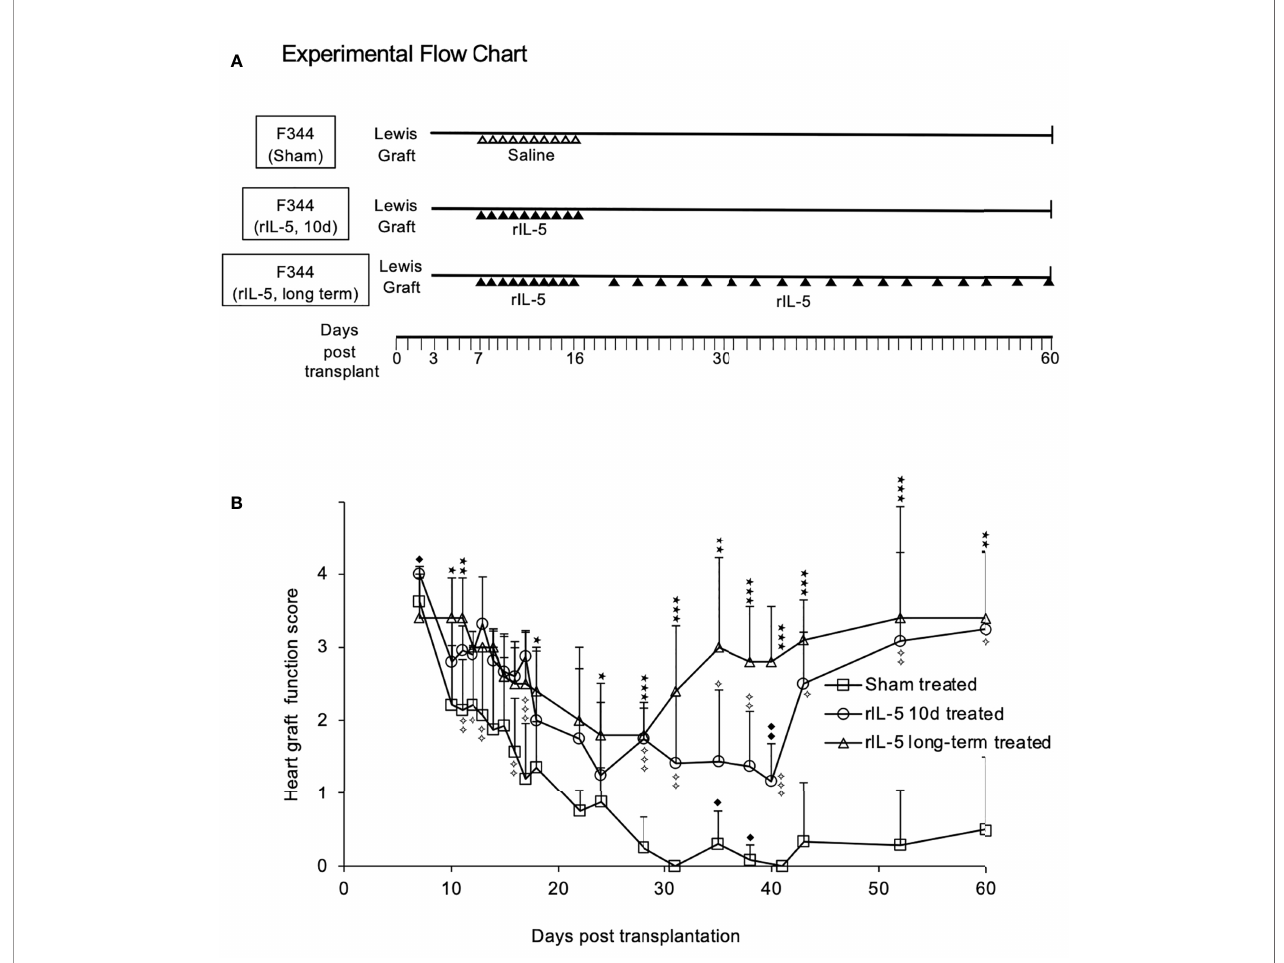
FIGURE 3 | IL-5 treatment prevents rejection of Lewis heart grafts in F344 hosts. (A) Experimental Flow Chart. Groups of F344 rats with heterotopic Lewis heart grafts were studied. Sham treated rats received saline (ipi) daily from day 7-16 post-transplantation. One treatment group (short-term rIL-5) received 5000 units/day of rIL-5 (ipi) from day 7 to 16 post-transplant. The second treatment group (long term IL-5) received rIL-5 therapy 5000 units/day from day 7-16 and beyond 16 days had three ipi of 5000 units rIL-5 per week until 60 days post transplantation. (B) Monitoring of F344 rats with Lewis heterotopic cardiac allografts. Severity of rejection was assessed by palpation and scored on a semi-quantitative scale, described in methods. Severity of rejection scores in each group was expressed as mean ± standard deviation. Sham treated ( □ ) received daily injections of 0.5ml of normal saline ipi starting at day 7 through to day 16 (n=5). All grafts had severe rejection by day 21. After 28 days, the mean score was <0.5 and there was no recovery of graft function. Short term rIL-5 treatment for 10d ( ○ ). 5000 units of rat rIL-5 was given daily ipi in 0.5ml from day 7 through to day 16 (n= 12), as described (22). Rejection was signi fi cantly less than sham treated on day 16 (p<0.01) and at day 17 (p<0.001). From day 28, graft function improved and was signi fi cantly greater than sham treated controls until day 60 (p<0.05). Signi fi cance compared to sham treated controls; ✧ p<0.05, ✧✧ P<0.01; ✧✧✧ p<0.001. Long-term rIL-5 treated ( △ ). 5000 units of rat rIL-5 in 0.5ml was given ipi in 0.5ml daily from day 7 through to day 16, then 3 times a week until day 60 (n= 5). Rejection in this group was signi fi cantly less (p<0.01) than sham treated group from days 19 until day 63. Rejection was signi fi cantly less than the group treated with rIL-5 for 10 days from day 32 until day 50 (p<0.05). The long-term rIL-5 treated group had less rejection than the short-term rIL-5 treated group at day 34 and day 38 (p<0.05) and at day 40 (p<0.01). By day 43, both rIL-5 treated groups had a mean graft score of 3 . Signi fi cance compared to sham treated; *p < 0.05, **p < 0.01; ***p < 0.001. Signi fi cance compared to 10 day rIL-5 treated ◆ p<0.05, ◆◆